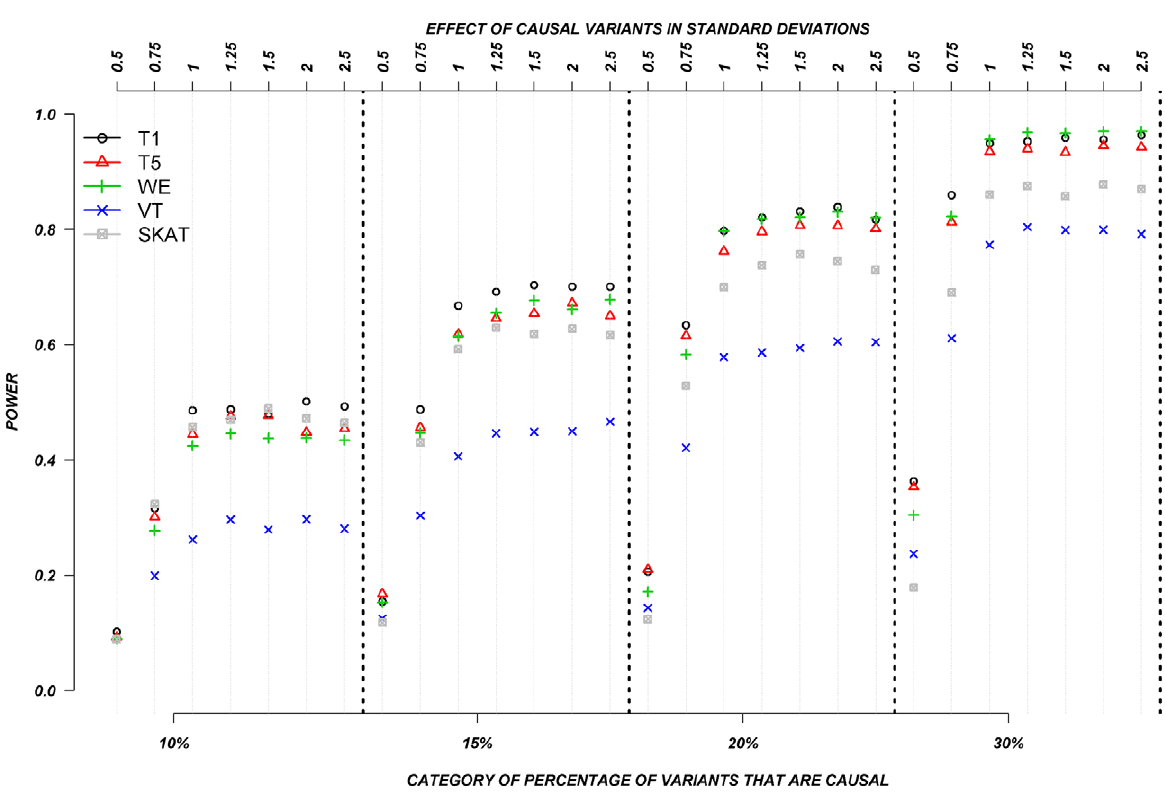
Figure 5. Dichotomous traits: Relationship between effect size, proportion of causal variants, and power, when causal variants only have a deleterious effect. Each box corresponds to a different proportion of causal variants involved in the relationship between rare variants and continuous traits (from left to right, 10, 15, 20 and 30%). On the x-axis, effect sizes are in standard deviations and correspond to the absolute value of the average size effect.